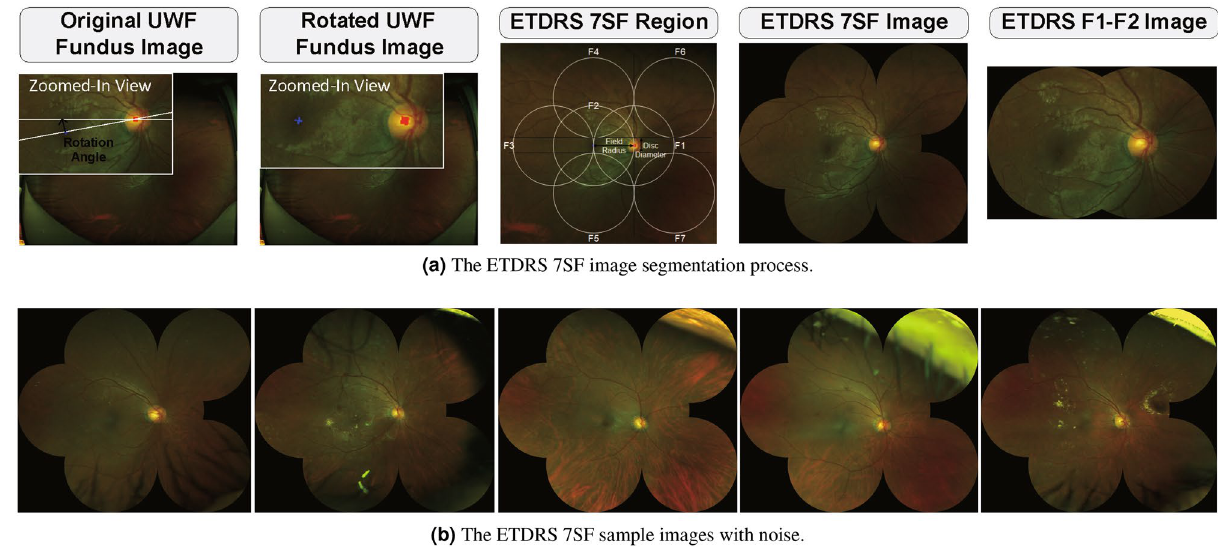
Figure 4. The ETDRS 7SF image segmentation process and sample images with